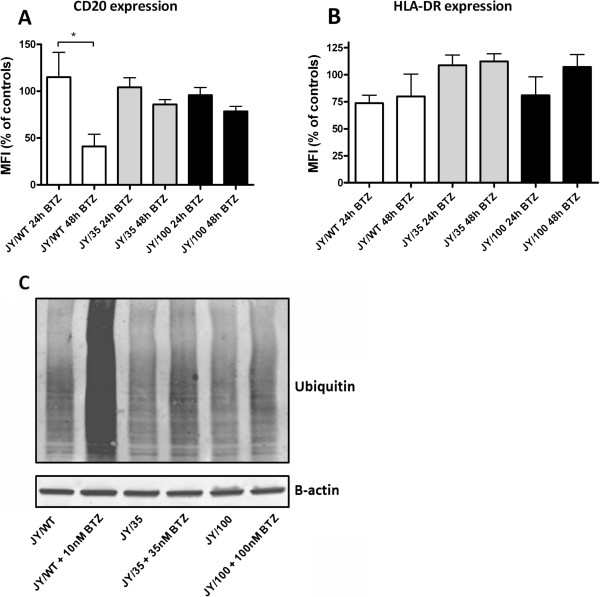
Effect of BTZ on CD20 (A) and HLA-DR (B) expression in JY/WT and BTZ-resistant JY cells. Short term incubations of 24 hours and 48 hours were performed with 5nM BTZ for JY/WT, 35nM for JY/35BTZ cells and 100nM BTZ for JY/100BTZ cells. Results depicted are means ± SD of 3–4 separate experiments. * p < 0.05. (C) Western blot analysis of polyubiquitinated cellular proteins prior to and after 24 hours treatment of BTZ; JY/WT (± 10nM BTZ), JY/35 (± 35nM BTZ) and JY/100 (± 100nM BTZ). β-Actin is displayed as a loading control. Western blot image is representative of 3 separate experiments.